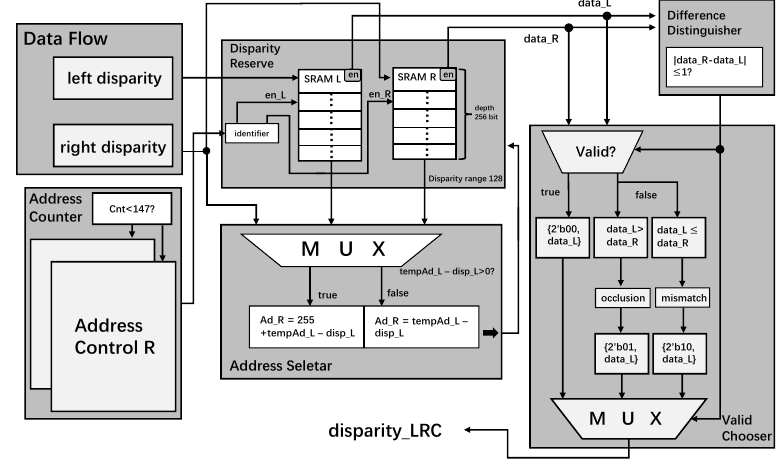
Figure 10. The Left-right Check Architecture .